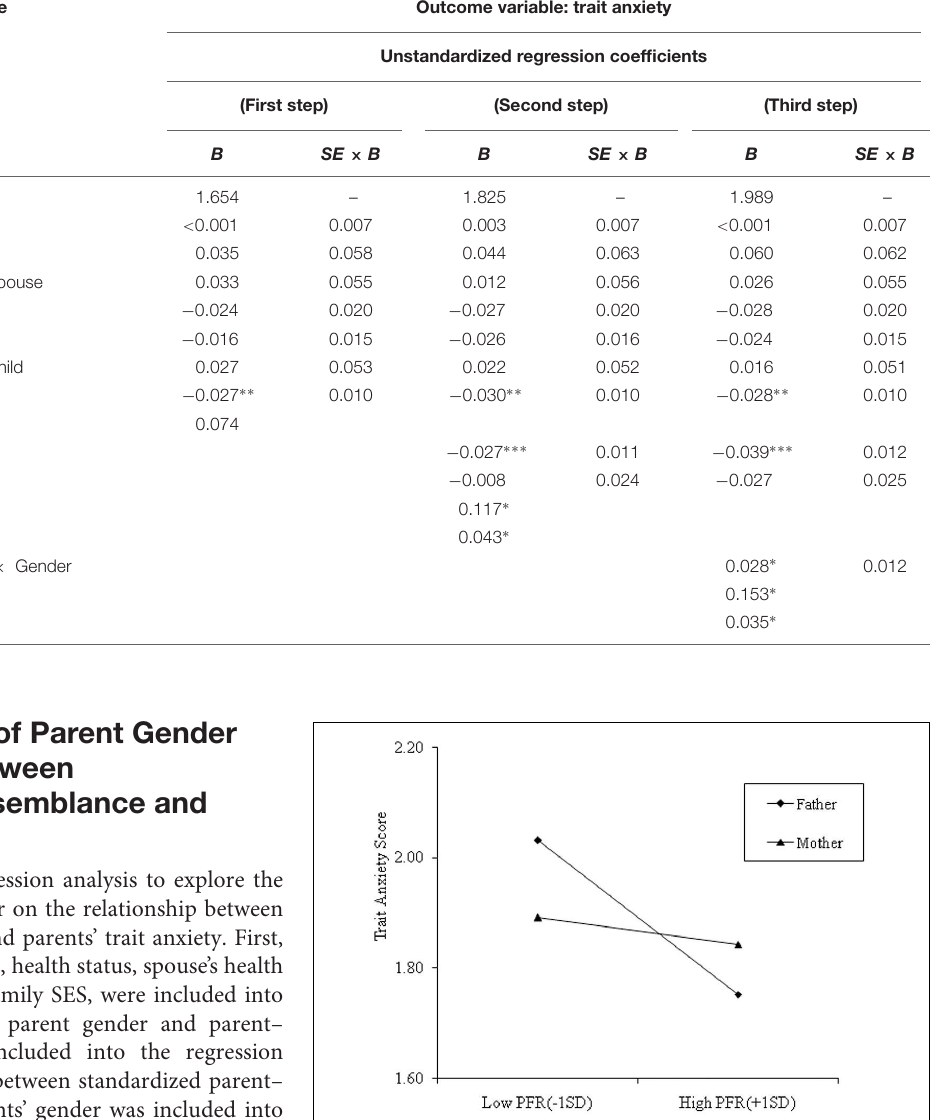
FIGURE 1 | The Moderating effect of parents’ gender on the relationship between perceived facial resemblance (PFR) and parents’ anxiety trait. The figure depicts the trait anxiety score corresponding to − 1SD and +1SD of PFR for both sexes. The slope was significant for men, but not for